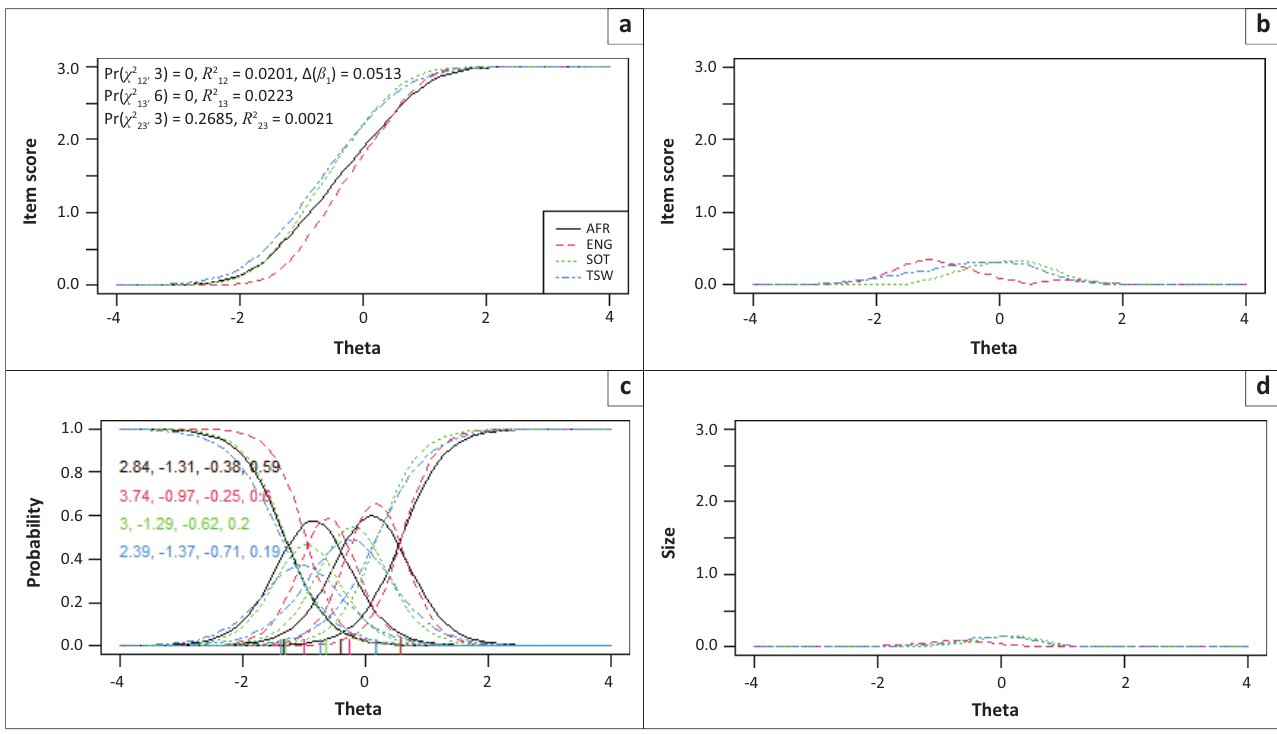
FIGURE 3: Graphical display of Item 7, which shows uniform and non-uniform differential item functioning with respect to language groups. (a) Items True Score Functions - item 7; (b) differences in items True Score Functions; (c) Item Response Functions; (d) Impact (weighed by density).